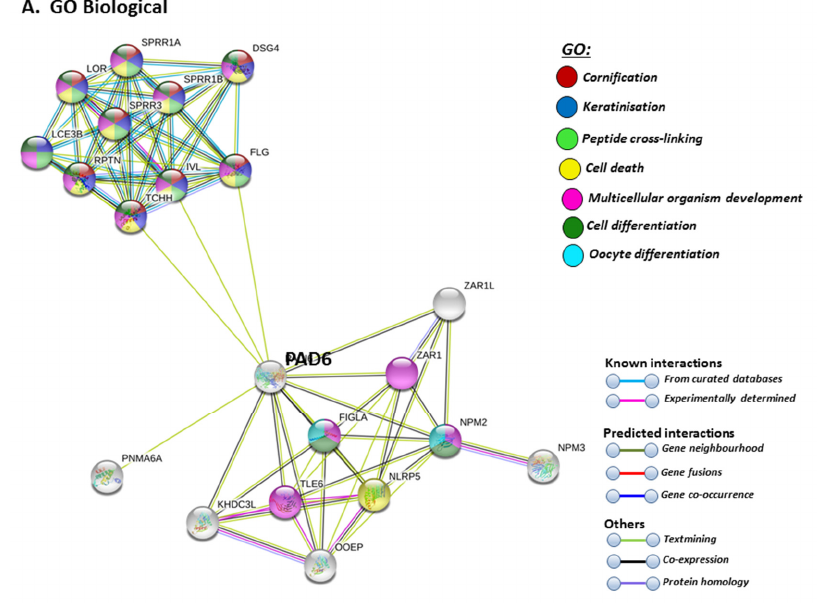
Figure 8. KEGG, GO and Reactome pathway analysis for PAD4, highlighting pathways relating to viral infections ( A ) Immune related GO biological pathways ( B ) Immune related Reactome pathways ( C ) and UniProt keywords ( D ) Colour code for the di ff erent pathways is shown within the figure. Individual coloured lines represent specific protein interactions that have been identified through interactions that are known (referring to experimentally determined connections and curated databases), through interactions that are predicted (referring to gene fusion, gene neighbourhood, gene co-occurrence) or through interactions identified via text mining, co-expression or protein homology (please refer to the colour key provided in the figure for the different connective lines) (PPI enrichment p -value: 1.21 × 10 − 5 ).